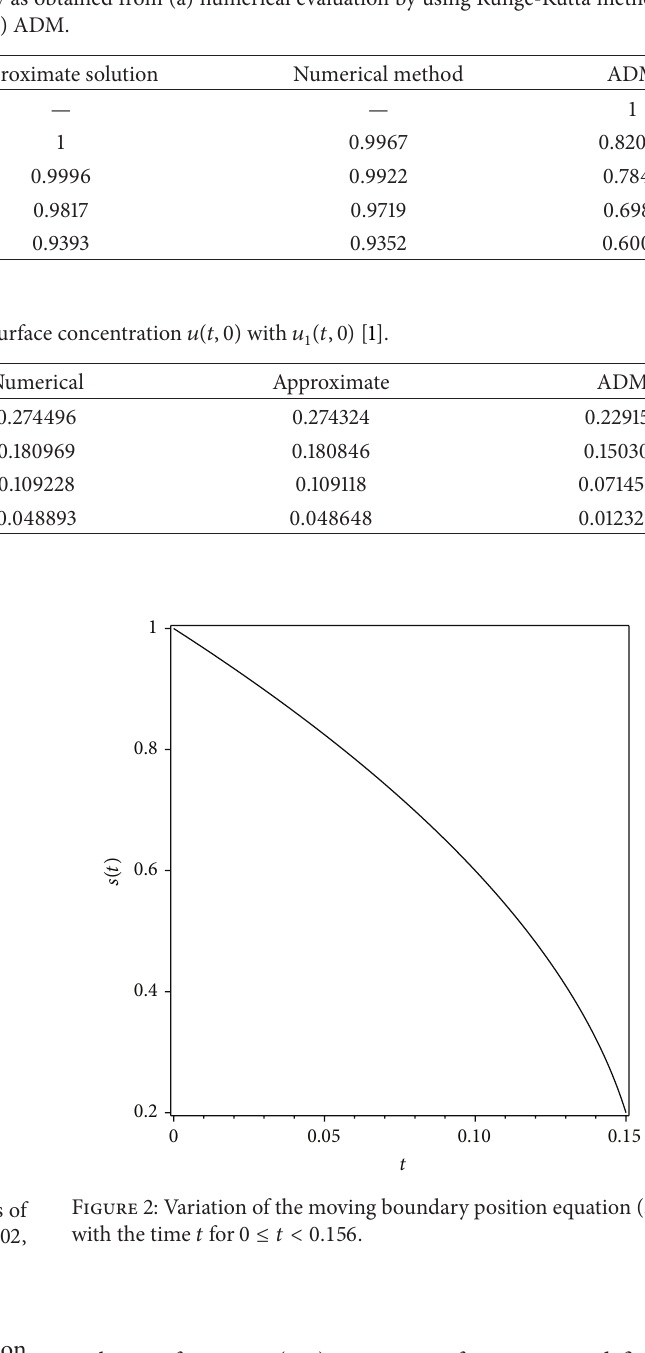
Table 1: A comparison for the position of the moving boundary as obtained from (a) numerical evaluation by using Runge-Kutta method,